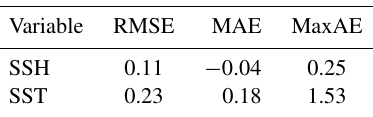
Table 4. Summary of the deviations for the SSH (m) and SST ( ◦ C) of the Moana Ocean Hindcast simulation compared to the AVISO and the OISST observational gridded products, respectively. Statis- tics for the RMSE, mean absolute error (MAE) and maximum ab- solute error (MaxAE) are